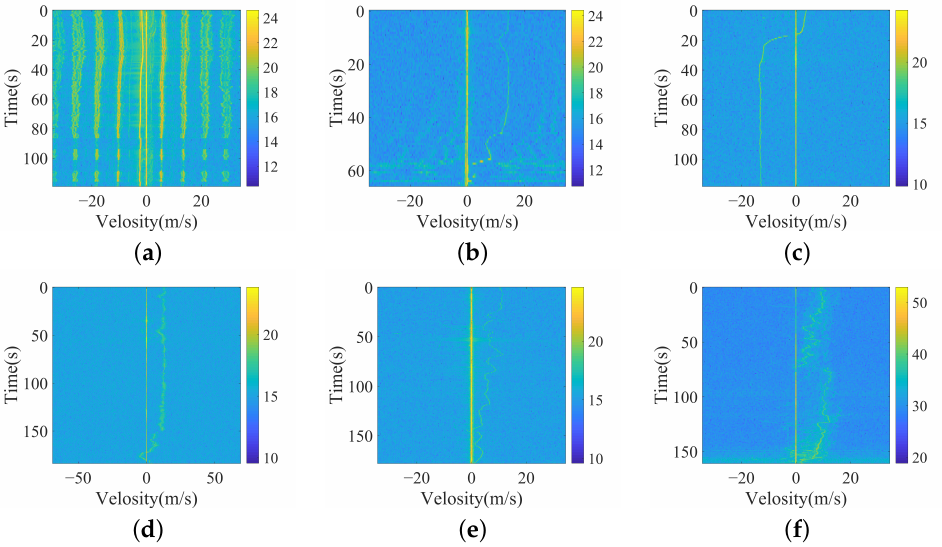
Figure 1. Spectrograms of UAVs and birds. ( a ) Inspire2 UAV. ( b ) Inspire2 UAV moves towards the radar from far to near. ( c ) MAVIC Air2 UAV. ( d ) a bird. ( e ) a small bird. ( f ) a group of